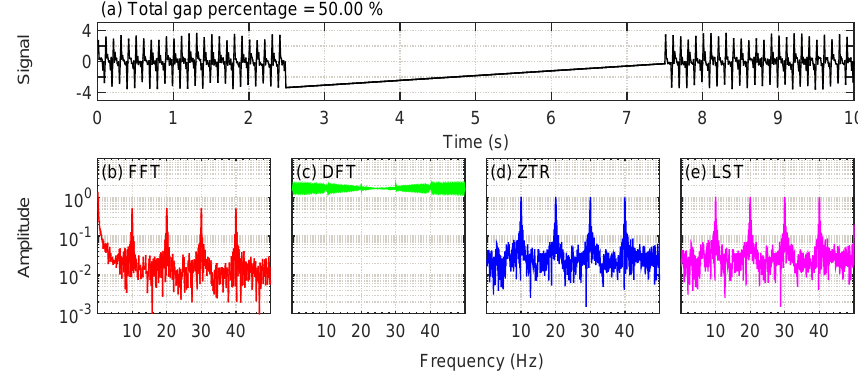
Figure 2. Case study for the SLG test applied to synthetic data. Panel (a) shows the non-windowed signal with total gap percentage (TGP) of 50% and panels (b) , (c) , (d) and (e) show the corresponding amplitude spectra computed with the fast Fourier transform (FFT), the discrete Fourier transform (DFT), the Z transform (ZTR) and the Lomb–Scargle transform (LST). FFT is applied to the signal were the data gap was linearly interpolated, while the other three methods are applied to the signal containing the data gap. The TGP parameter represents the total number of points removed from the time series, and is defined as a percentage of the original length L .